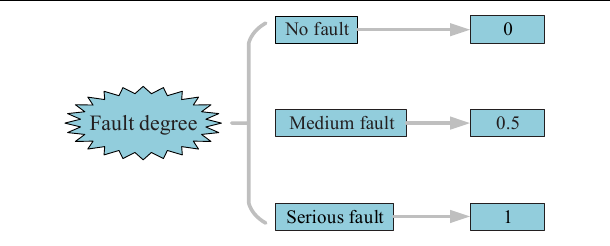
FIGURE 5 | Fuzzy numbers and event